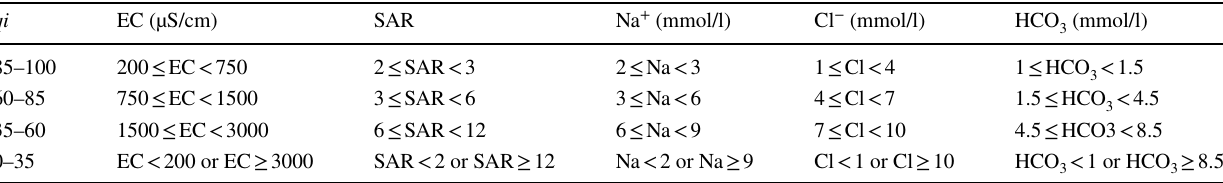
Table 3 Quality measurement for qi calculation (Meireles et al.